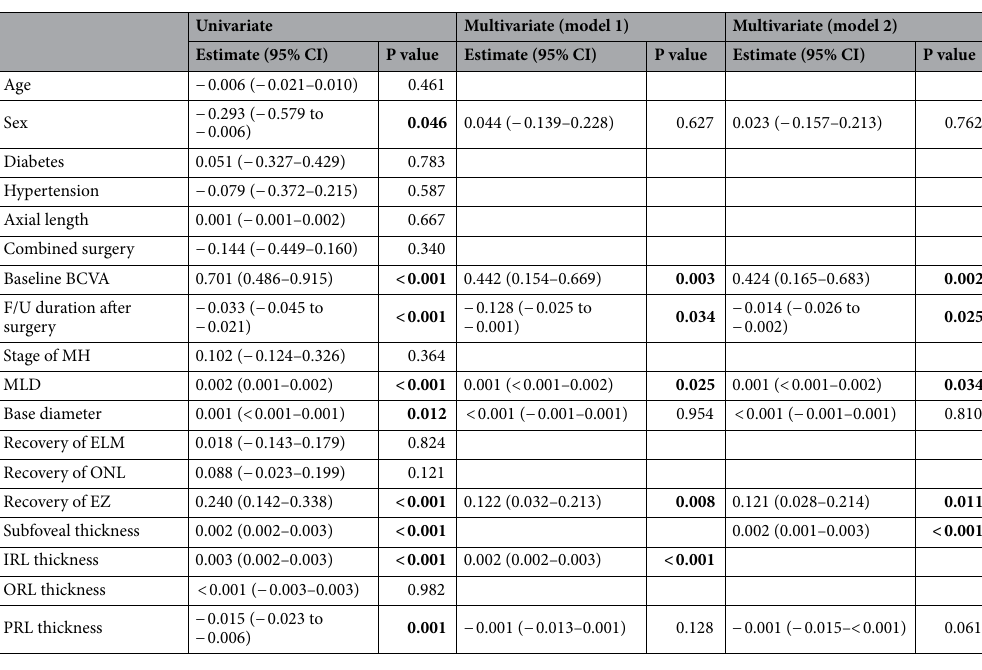
Table 4. Univariate and multivariate linear mixed model determination of factors associated with changes in the best-corrected visual acuity (BCVA). Values in boldface are statistically significant (P < 0.050). F/U follow-up, MH macular hole, MLD minimum linear diameter, ELM external limiting membrane, ONL outer nuclear layer, EZ ellipsoid zone, IRL inner retinal layer, ORL outer retinal layer, PRL photoreceptor layer.